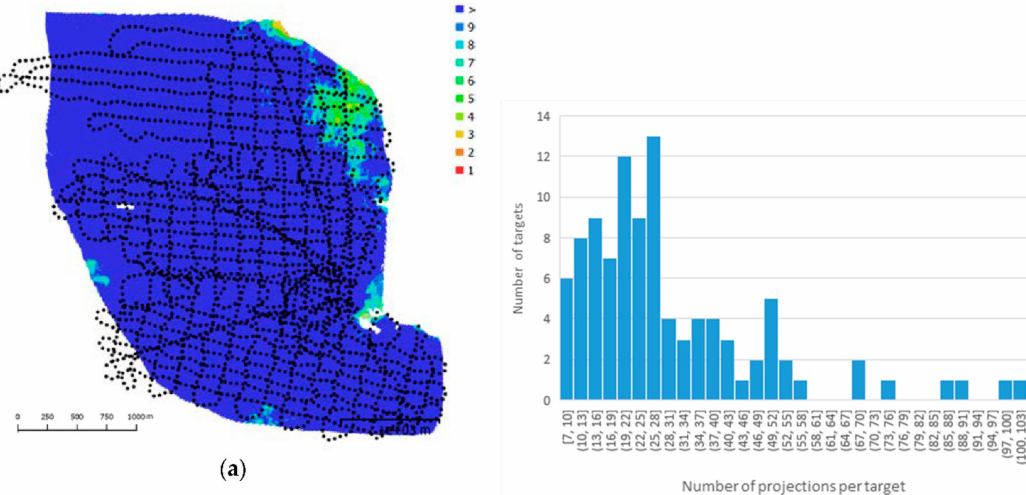
Figure 3. ( a ) The geographic distribution of the imagery (black points) and multi-view image count over the ground. ( b ) The histogram with the number of images in which a target